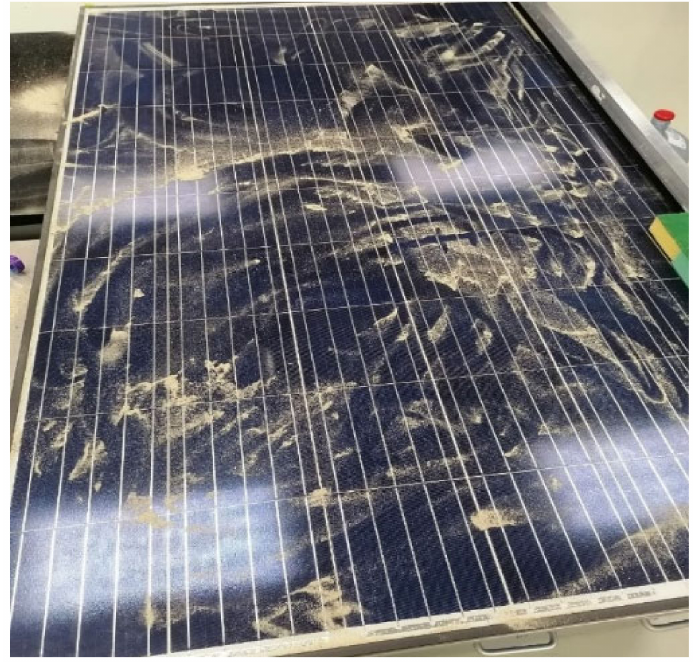
Figure 7. A prepared uncleaned PV module for the cleaning effectiveness